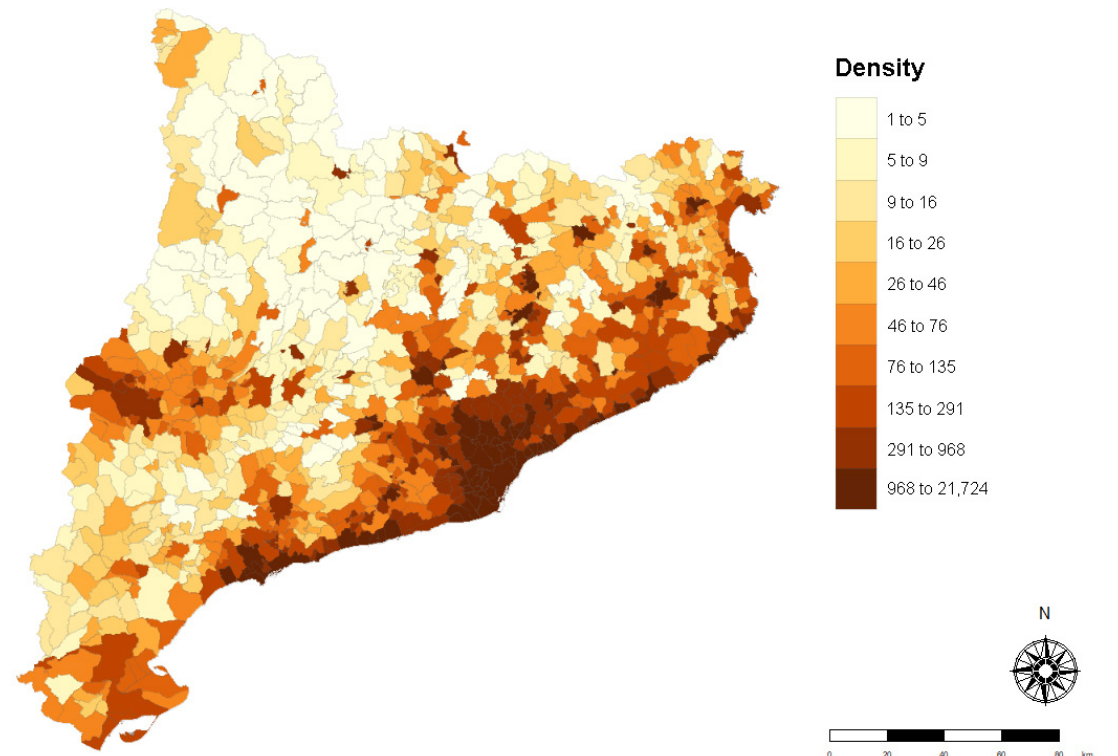
Figure 2. Map of the density of Catalonia by municipalities.